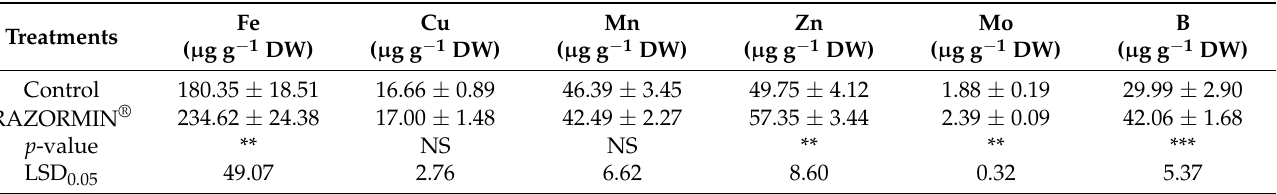
Table 6. Effect of the biostimulant RAZORMIN ® application on foliar content of